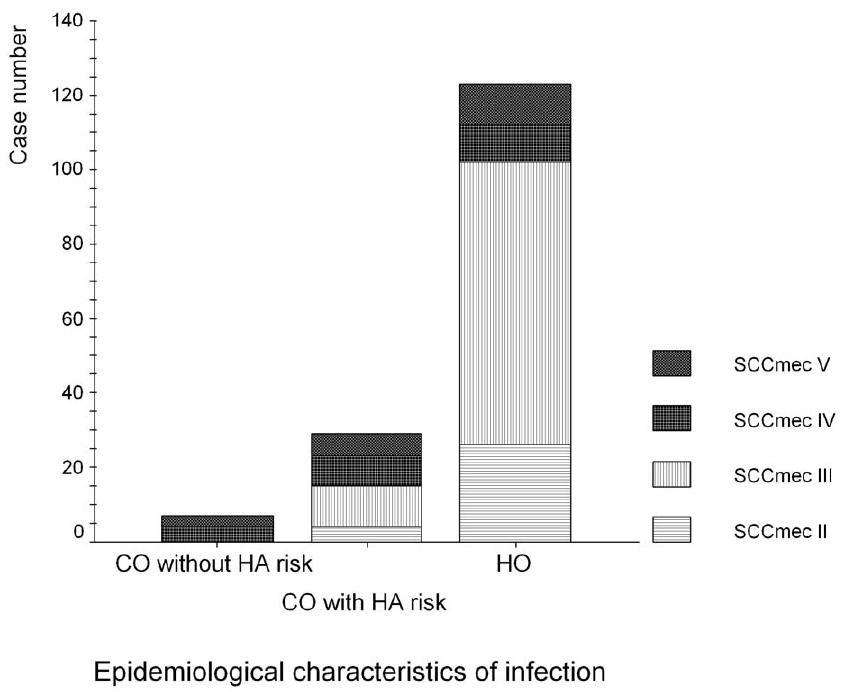
Figure 1. The distribution of SCCmec: community-onset (CO) or hospital-onset (HO) and healthcare-associated (HA) factor.